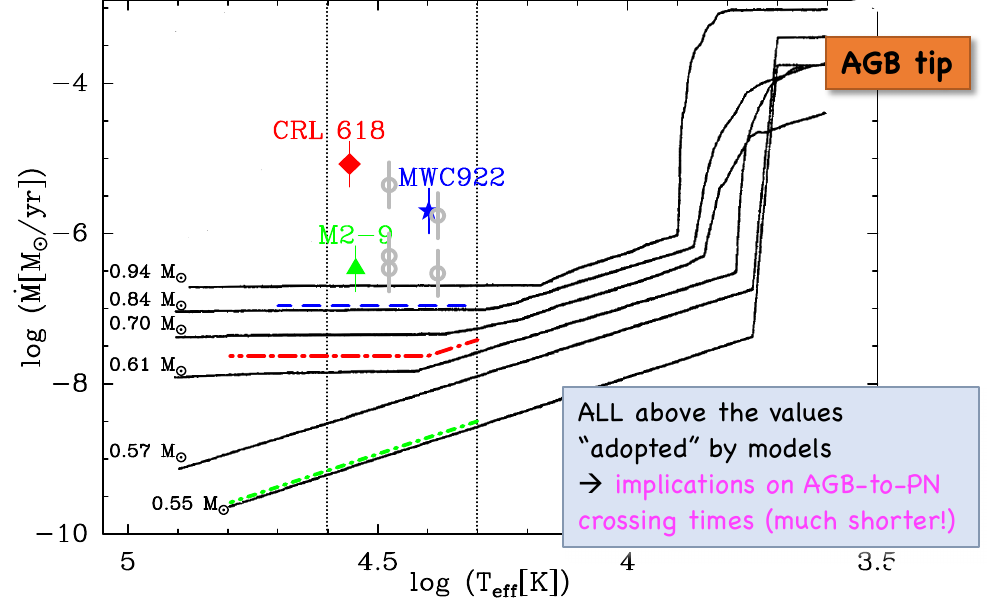
Figure 1. Adapted from Figure 8 of Sánchez Contreras et al. [58]. Post-asymptotic giant branch (post-AGB) mass-loss vs. effective temperatures adopted by post-AGB models (solid black lines) and empirically deduced (symbols). The thick dashed and dot-dashed lines indicate the mass-loss rates typically assumed by evolutionary models for the three objects in with mmRRL detections. See Sánchez Contreras et al. [58] for